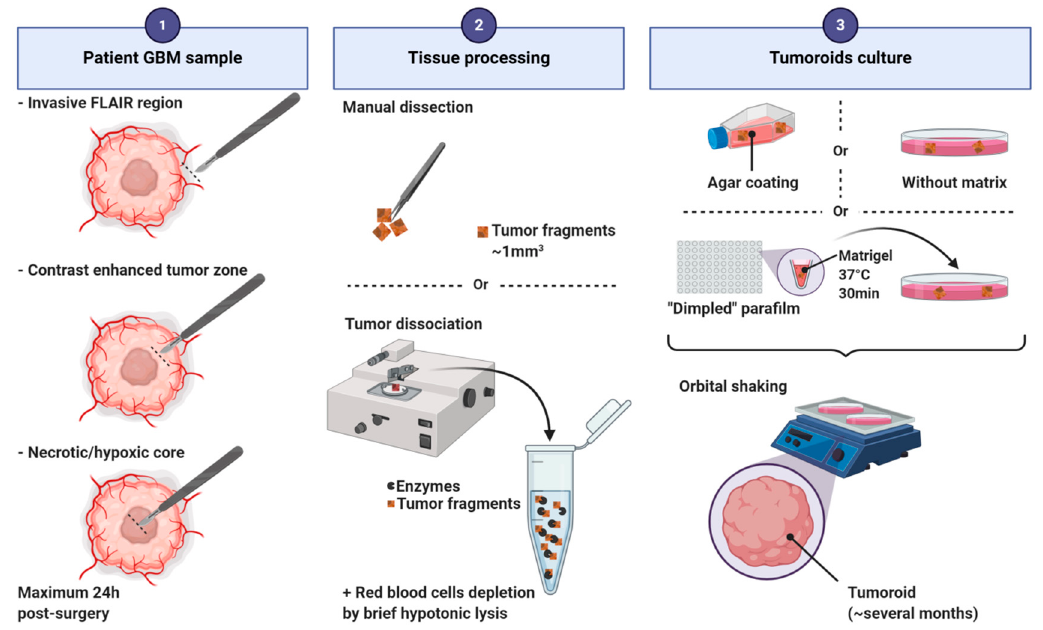
Figure 5. Main steps of the protocol for human glioblastoma tumoroid generation.